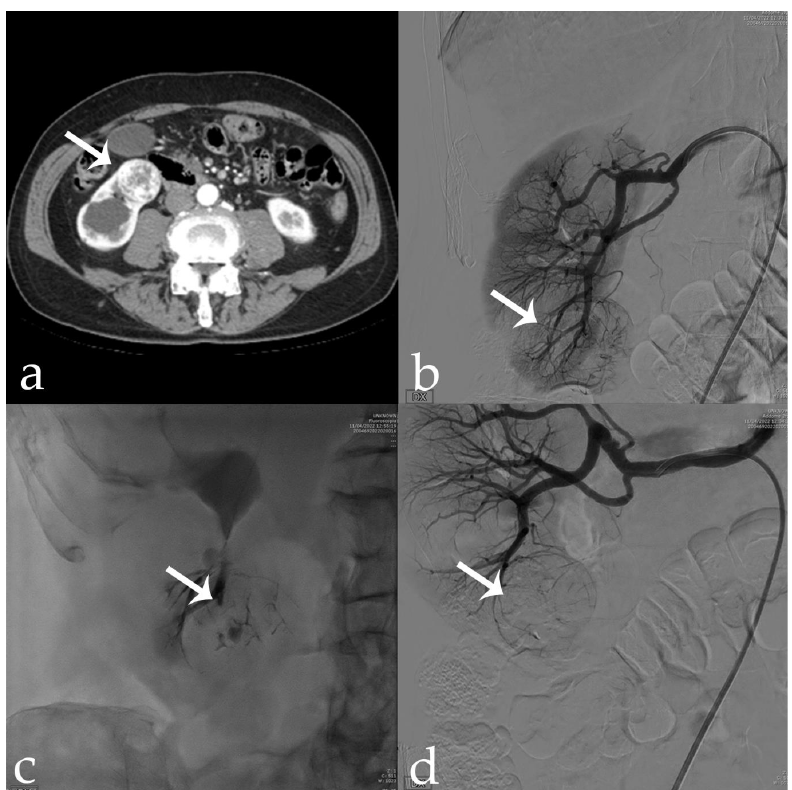
Figure 1. 78 yr old male with exophytic RCC of the anterior aspect of the lower pole of the right kidney (46 × 35 mm) (arrows): ( a ) pre-operative CECT; ( b , c ) tumor vascular supply on DSA evaluation; ( d ) post-embolization control showing complete devascularization and deep penetration of the 18-Onyx and indocyanine mixture.